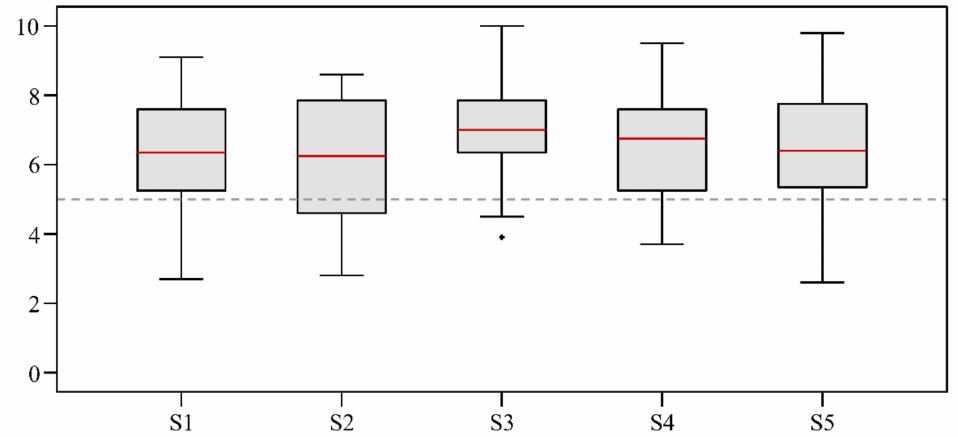
Figure 4. Comparison rating ‘ride’ between shoe conditions (“not smooth” (0) to “very smooth” (10)).